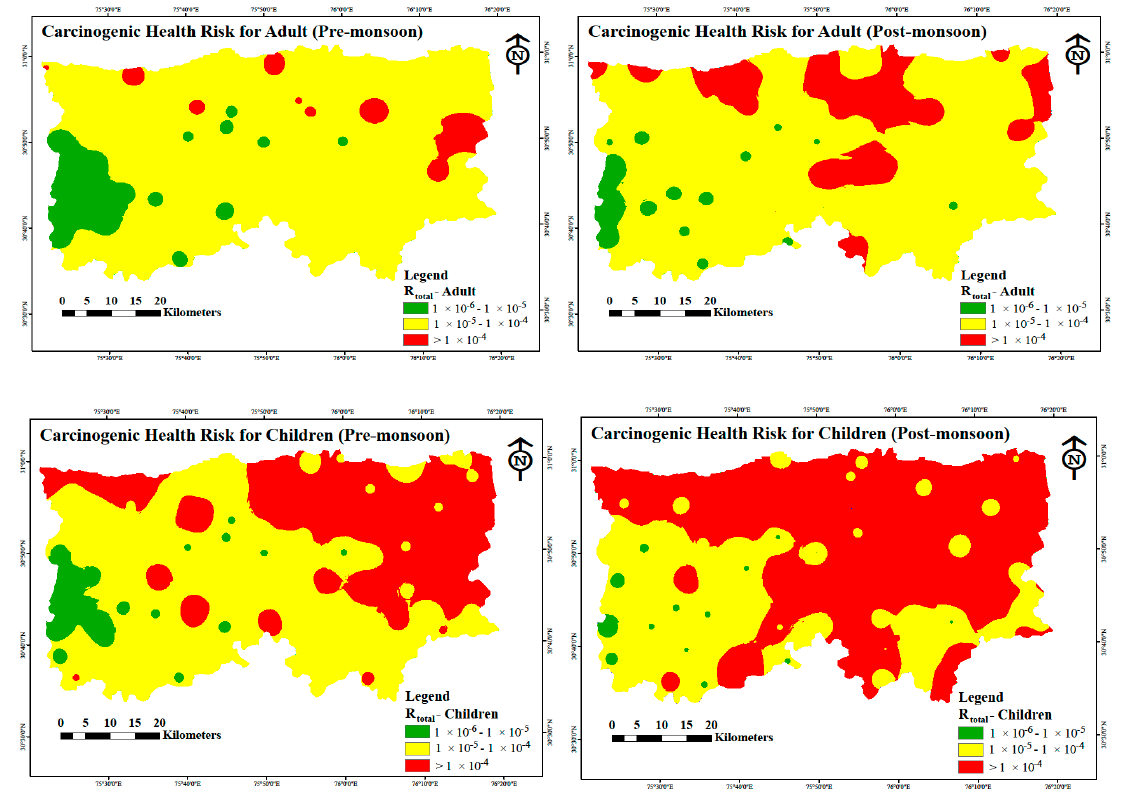
Figure 6. R total for adults and children during pre- and postmonsoon periods.